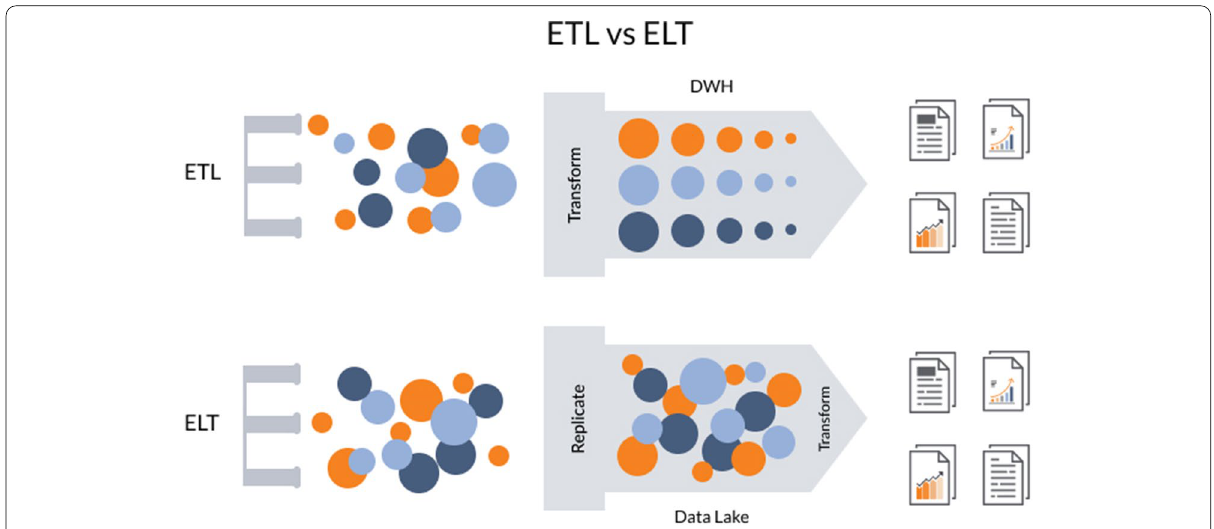
Fig. 6 Differences between ETL and ELT